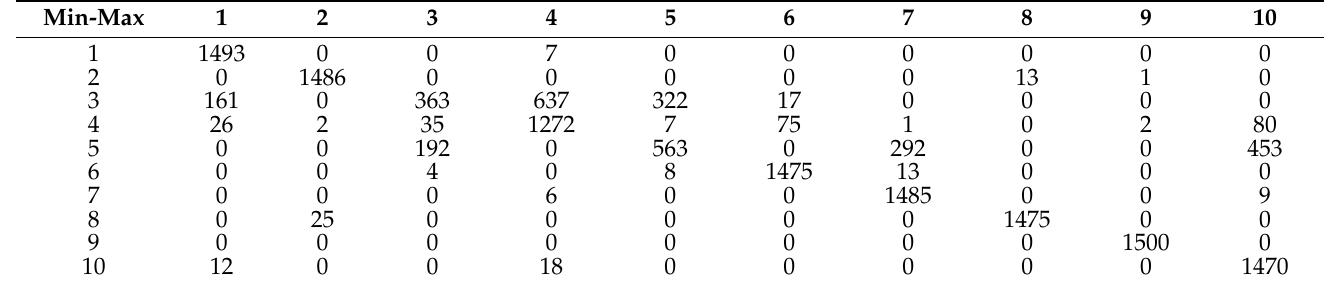
Table 6. The confusion matrix of hand gesture intention recognition by VGG-16 CNN deep learning with wavelet image fusion of the merge type of “min-max” on the recognition system test.